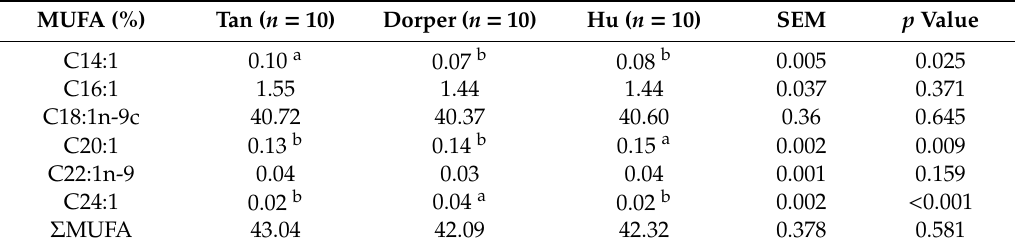
Table 4. E ff ect of breed on monounsaturated fatty acid (%) of